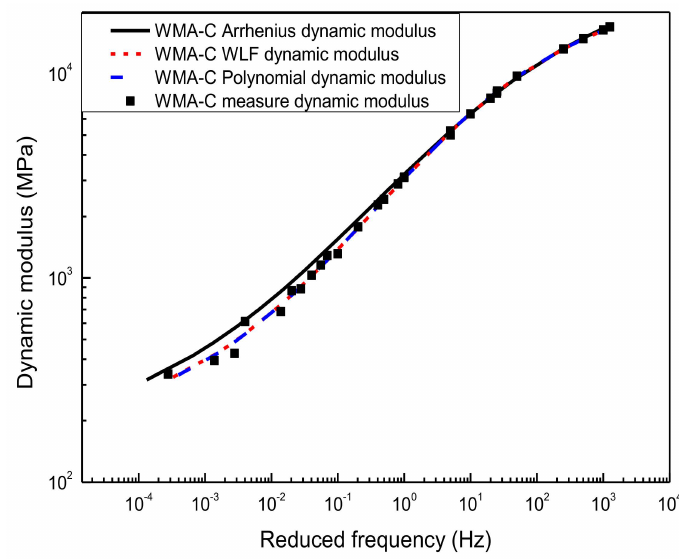
Figure 6. Sigmoidal dynamic modulus master curve of HMA-60.